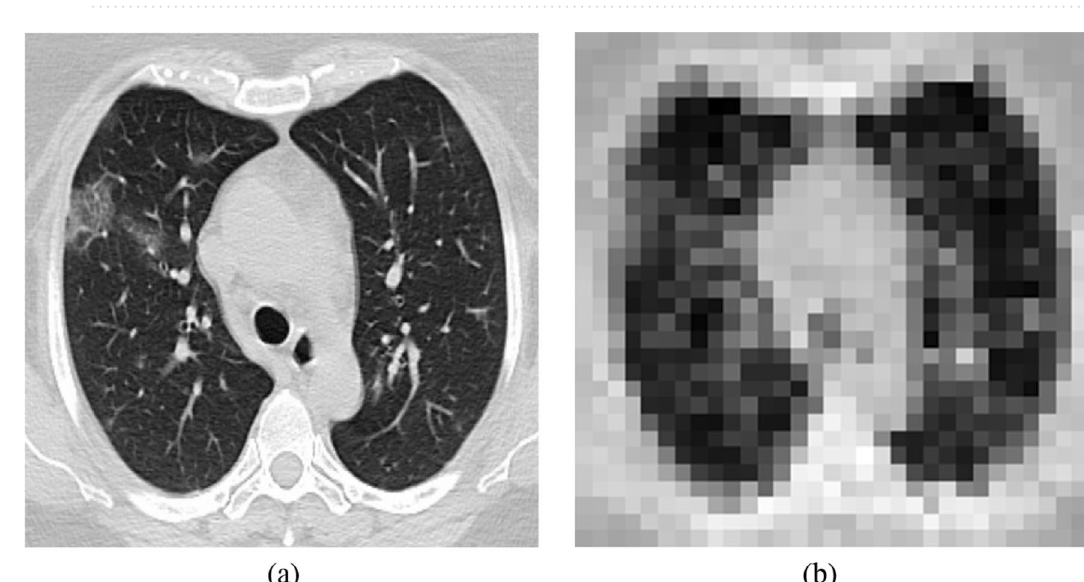
Figure 1. The overall framework of our multi-site split learning algorithm.